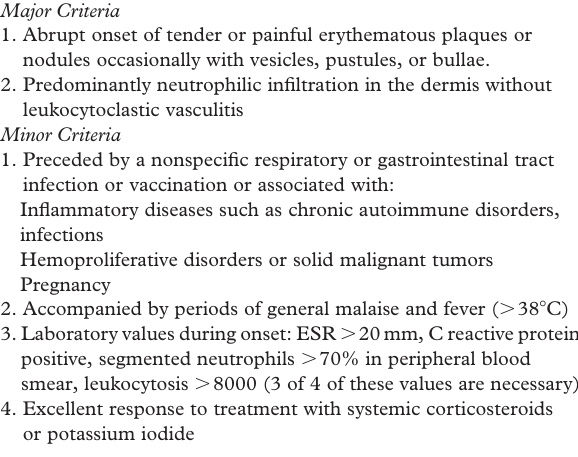
Table II. Preliminary criteria for the classification of Sjo¨gren’s